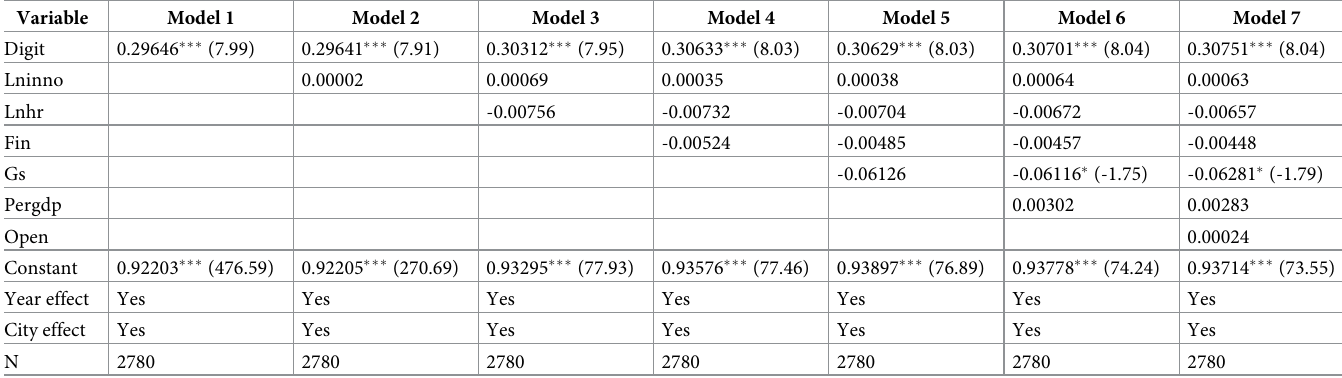
Table 4. Results of the benchmark